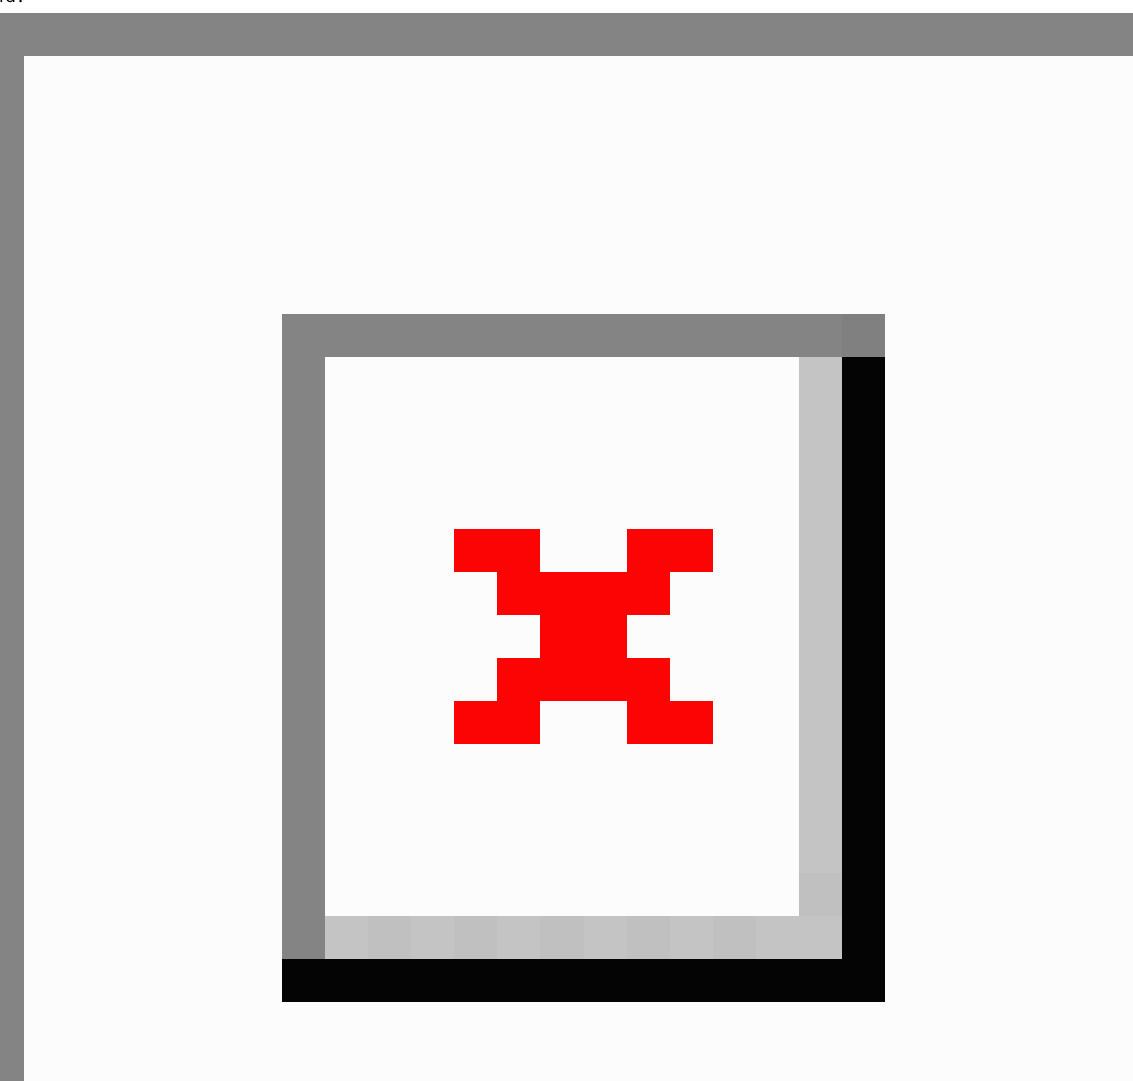
Figure 1. The smartphone was placed in a pocket near the third lumbar spine vertebra (L3) of the lower back. The screen of the smartphone faced